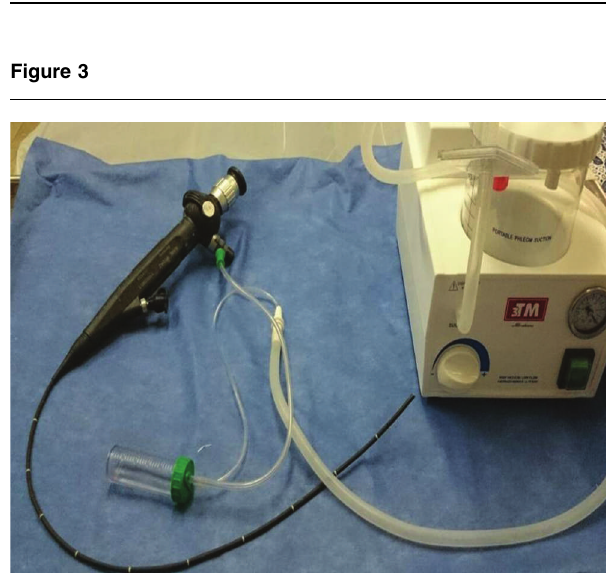
Aspirator suction with trap. Group III (AST